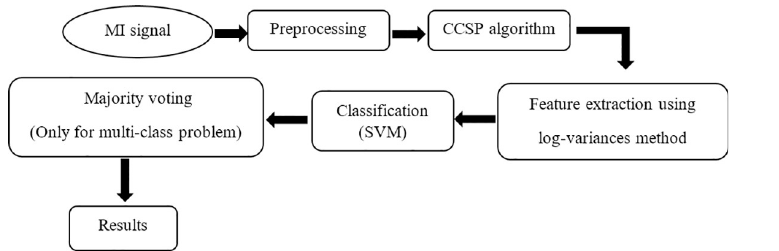
Fig 1. Block-diagram of the proposed